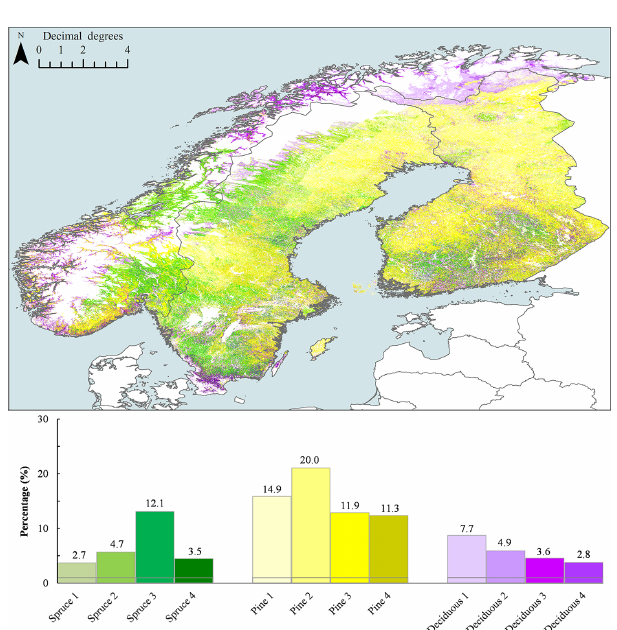
Figure 3. Spatial distribution of MS-NFI forest classes (i.e., with- out gapfilled forest pixels) in Fennoscandia. The first part of the x label is the species group and the number refers to the respective subgroup number (see Fig. 2.). The forest subgroup was assigned based on the most abundant forest class within the ESA LC